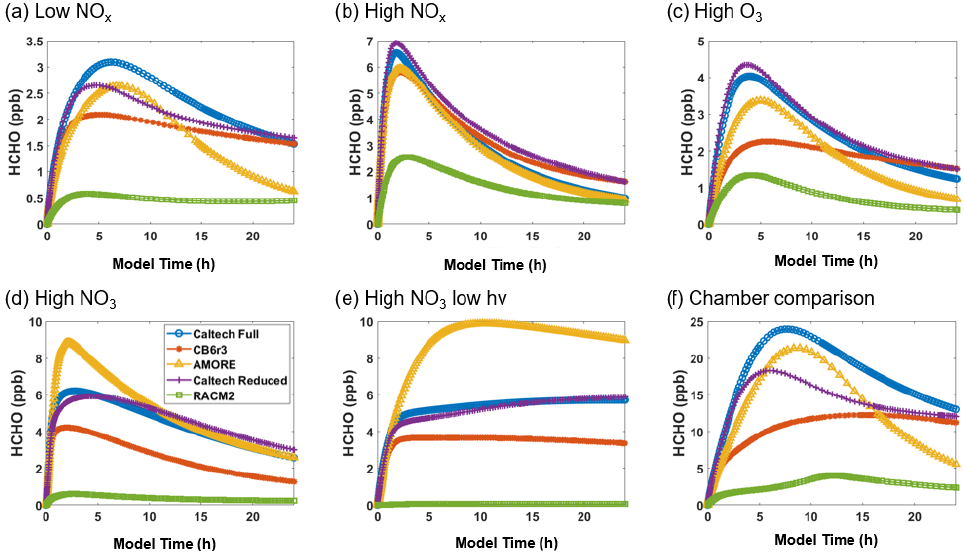
Figure 5. Box model predictions of formaldehyde from multiple mechanisms (292K and 1000hPa) under the following conditions: (a) low NO x ; (b) high NO x ; (c) high O 3 ; (d) high NO 3 ; (e) high NO 3 , low hv ; and (f) Paulot et al. (2009)